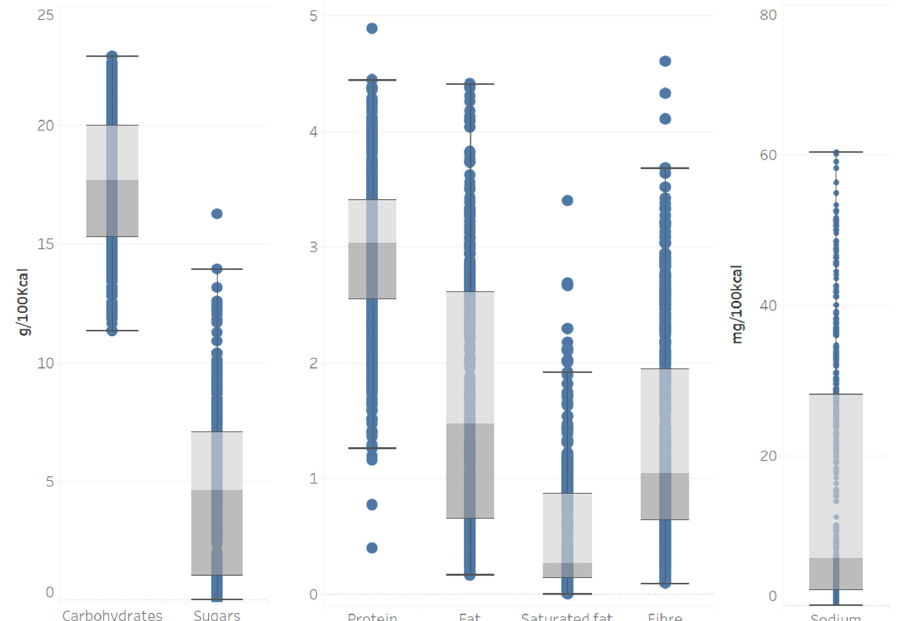
Figure A2. Nutrient content (g/100 kcal product, except for sodium mg/100 kcal product) of ‘Baby cereals’.